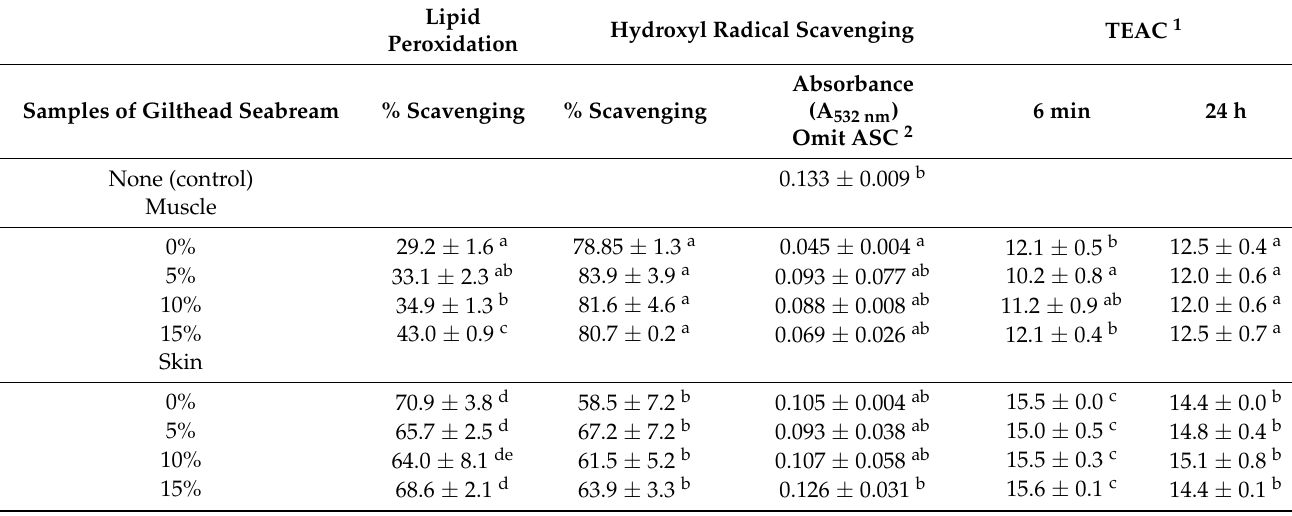
Table 1. Antioxidant activity of samples of gilthead seabream (muscle and skin) fed with and without supplemented diet with Moringa oleifera (MO) (5, 10 and 15%) for 4 weeks evaluated by different assays (lipid peroxidation, hydroxyl radical scavenging and TEAC). All determinations were performed in triplicate and values shown are mean ± standard deviation. Different superscript letters indicate significant differences ( p < 0.05).